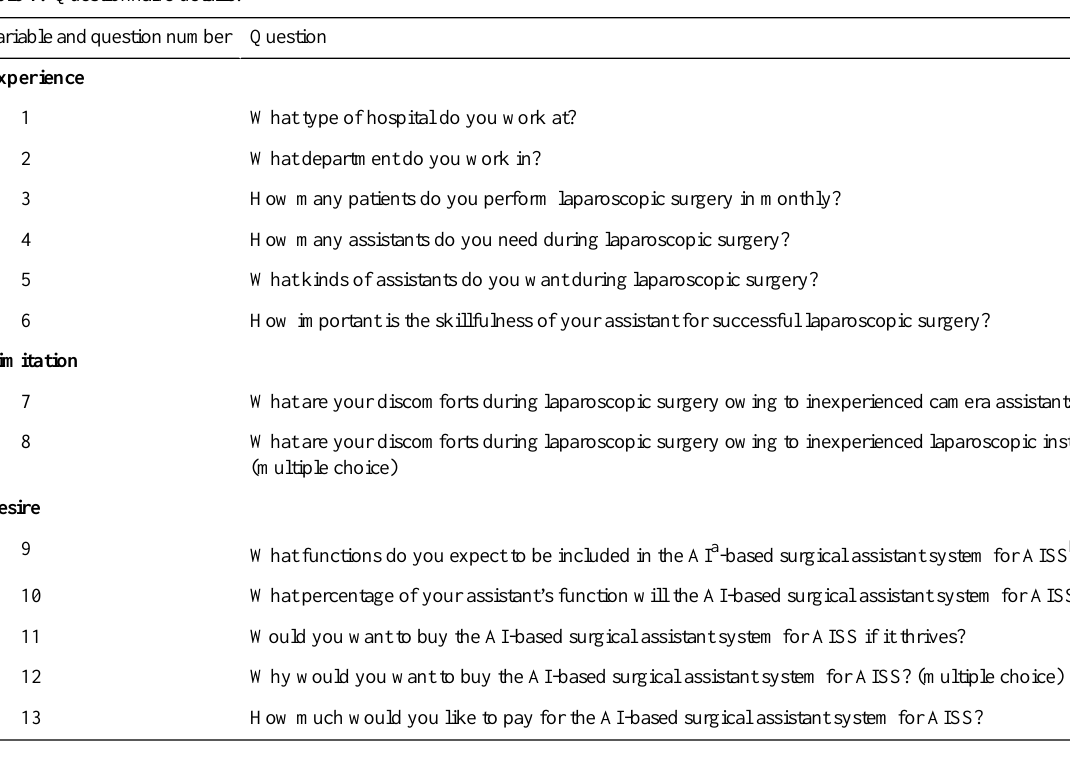
Table 1. Questionnaire